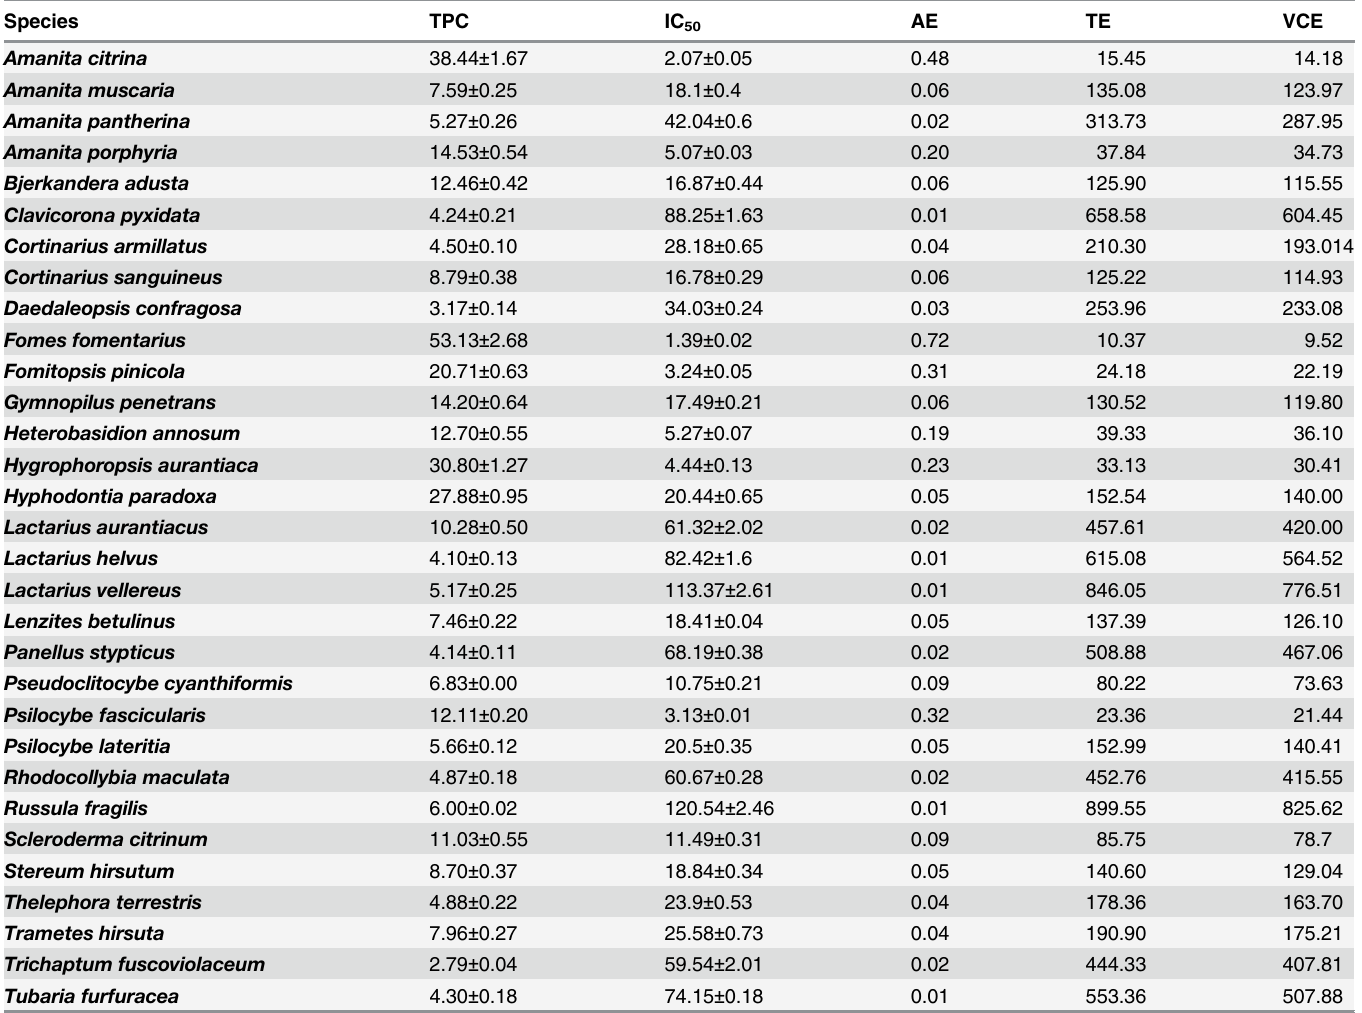
Table 1. Total phenolic content (TPC) and antiradical activity of mushroom extracts. TPC expressed as mg of gallic acid equivalents per gram of dried extract; IC 50 expressed as mg of dry extract per mg DPPH ● ; AE — antiradical efficiency (1/IC 50 ); TE — Trolox equivalent; VCE -ascorbic acid equivalent. Equiv- alents were calculated by dividing extract mean IC 50 by standard mean IC 50 . For Trolox IC 50 = 0.134 mg/mg DPPH ● ; for ascorbic acid IC 50 = 0.146 mg/mg DPPH ● . Mean values of three replicate assays with standard